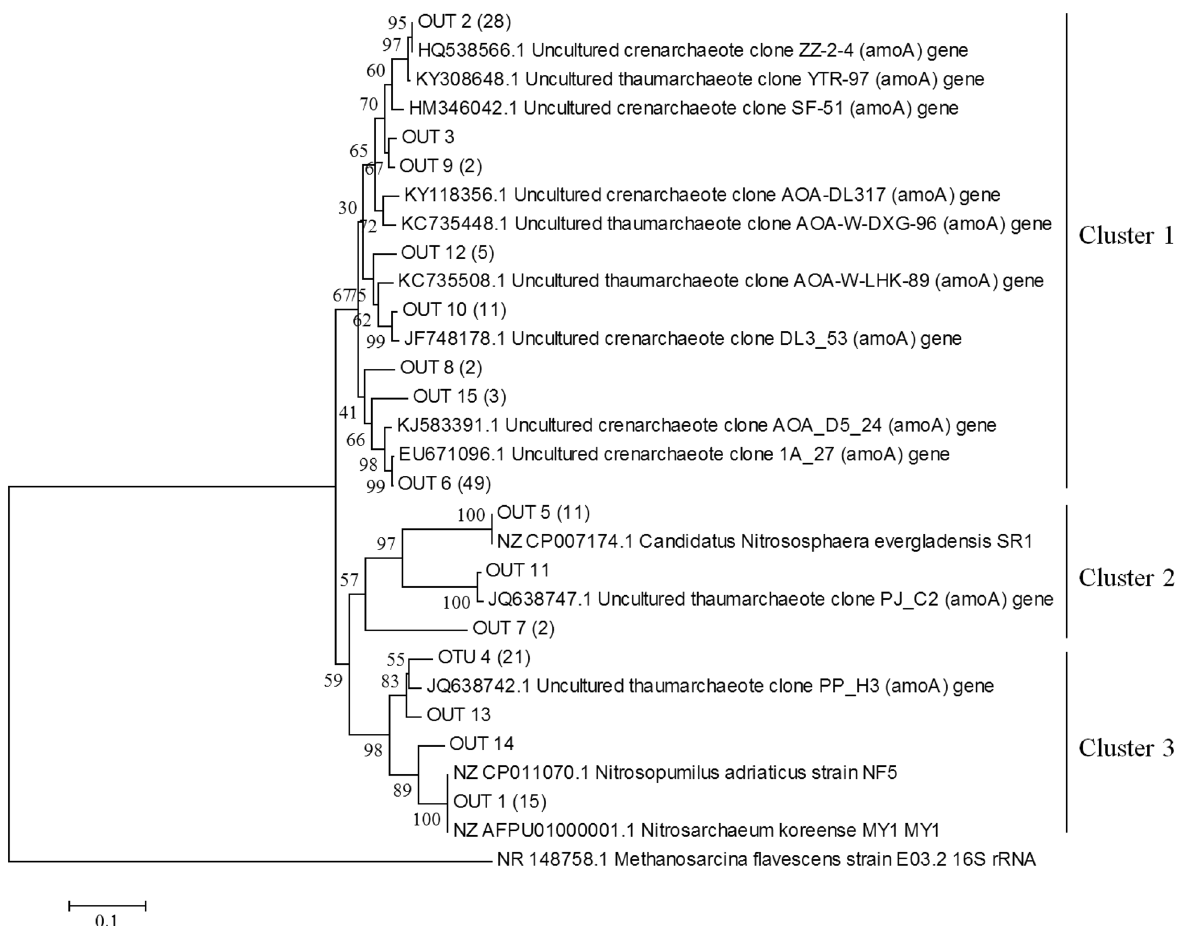
Figure 5. Neighbour-joining phylogenetic tree based on ammonia oxidizing archaeal amoA amino acid sequences. Clones with > 96% sequence similarity were considered as the same OTU and were named with OTU and numbers. Additional amoA sequences were obtained from the GenBank database. The scale bar represents 1% sequence